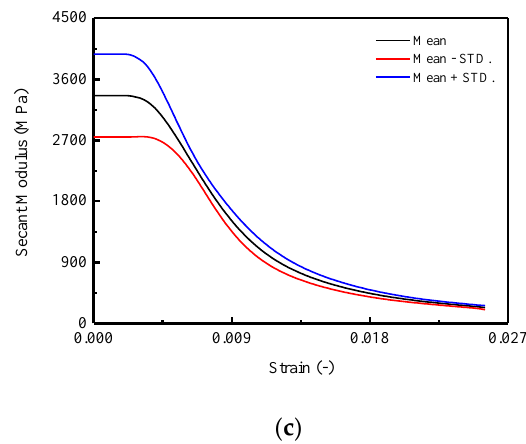
Figure 4. Secant modulus of CA mortar specimens: ( a ) secant modulus; ( b ) mean and STD. of secant modulus; ( c ) Mean ± STD. of secant modulus.